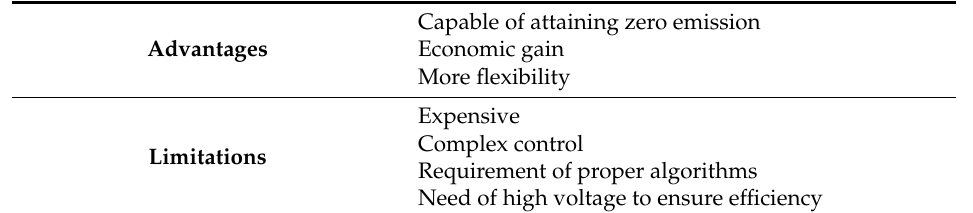
Table 3. Advantages and limitations of parallel hybrid configuration. Adapted from [30].